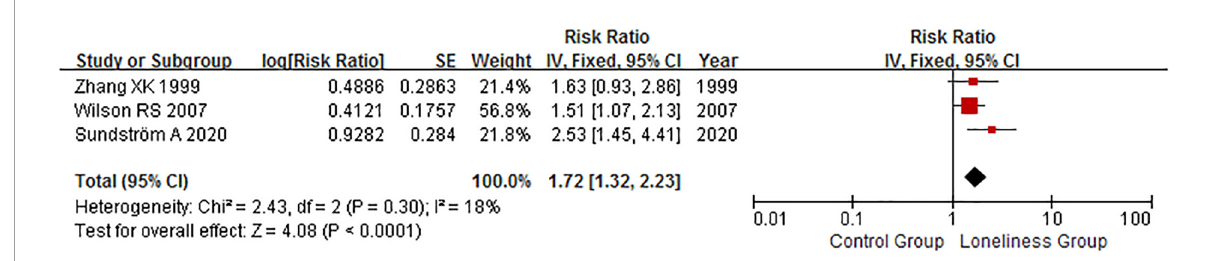
FIGURE2 Fixed effects analysis of fully adjusted studies for the association between loneliness and Alzheimer’s disease (AD) risk. The square box in the graph portrays the weight that each study contributed to the analysis. CI, confidence interval; IV, inverse variance; SE, standard error; AD, Alzheimer’s